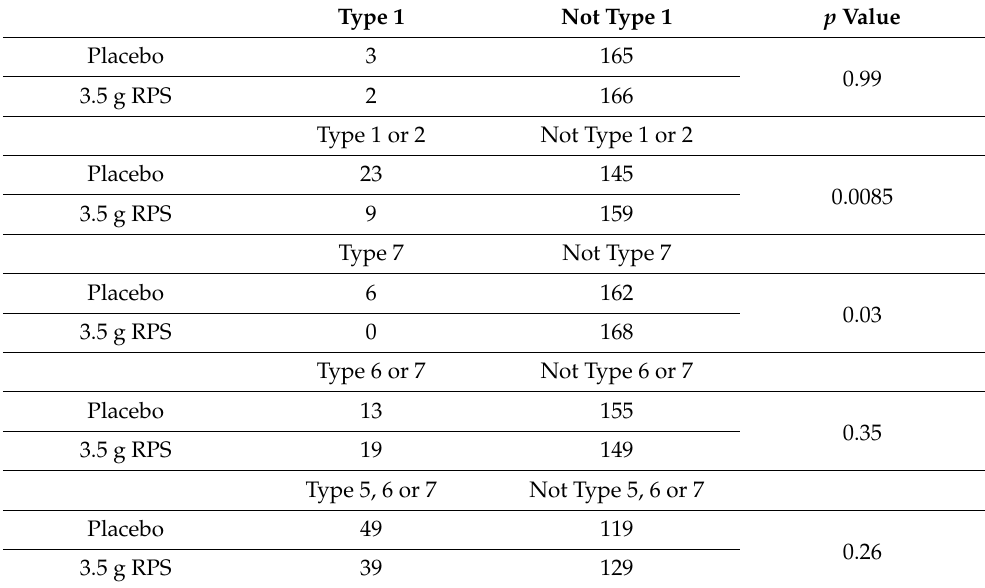
Table 4. The presence of bowel movements scored according to the Bristol Stool Chart (BSC) at 4 weeks in the 3.5 g RPS and placebo arms.